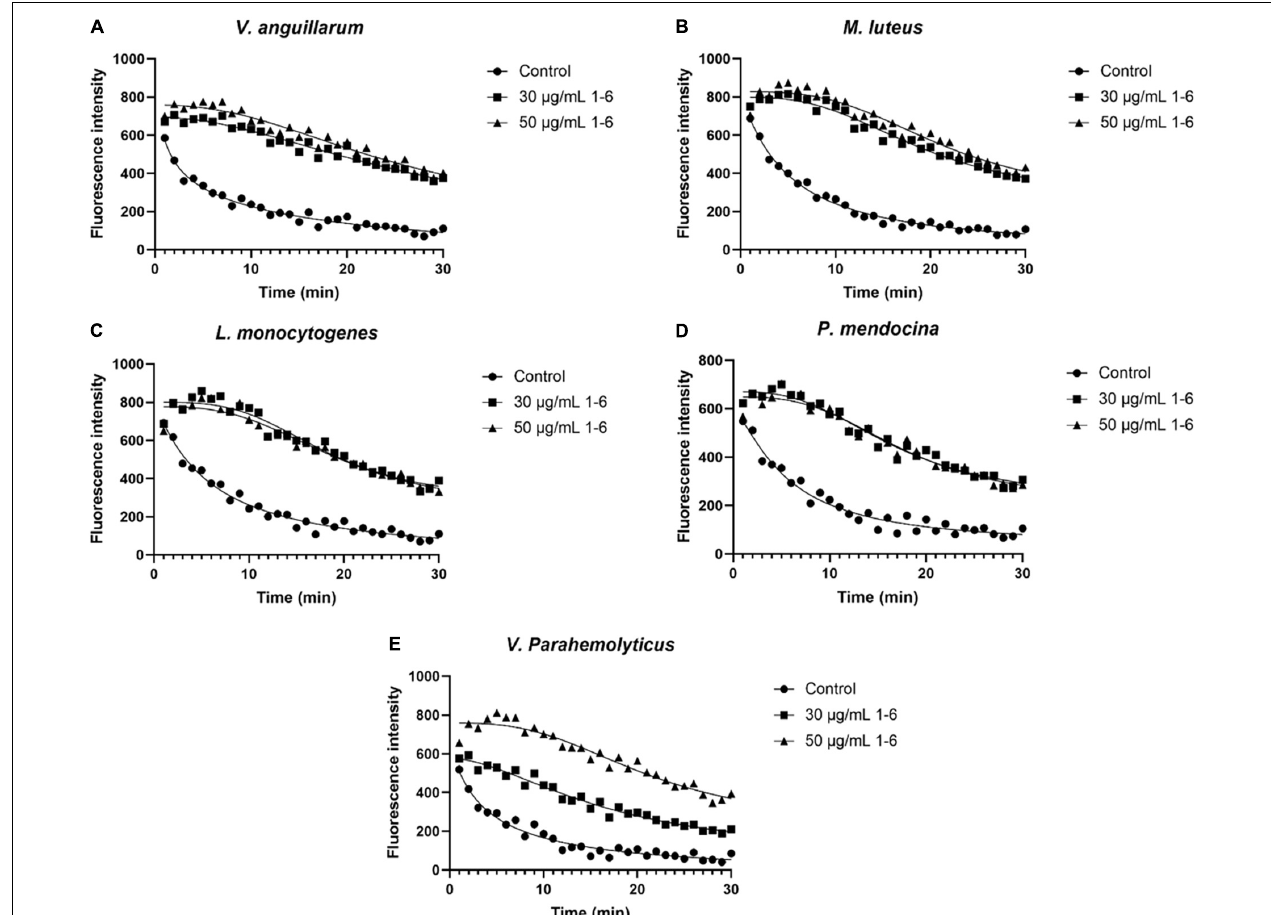
FIGURE 7 | Bacterial membrane depolarization. Depolarization of the bacterial membrane after incubation with antimicrobial peptides 1–6 was detected using DiSC 3 -5 (excitation, 622 nm; emission, 670 nm). (A) Depolarization of cell membrane of V. anguillarum incubated with antimicrobial peptides 1–6. (B) Depolarization of cell membrane of M. luteus incubated with antimicrobial peptides 1–6. (C) Depolarization of cell membrane of L. monocytogenes incubated with antimicrobial peptides 1–6. (D) Depolarization of cell membrane of P. mendocina incubated with antimicrobial peptides 1–6. (E) Depolarization of cell membrane of V. parahaemolyticus incubated with antimicrobial peptides